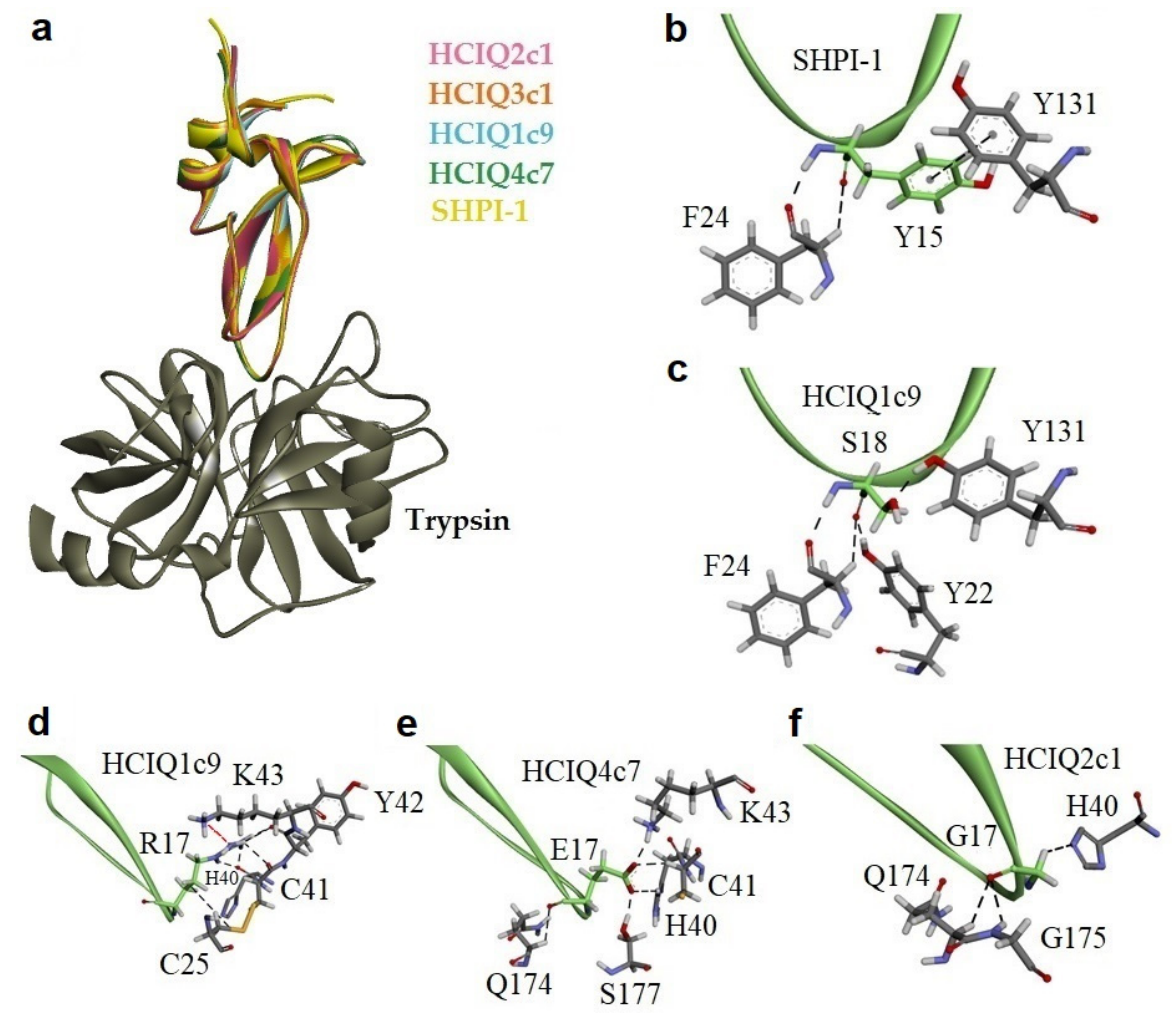
Figure 4. Comparative models of the peptide complexes with trypsin. ( a ) Ribbon representation of peptide complexes. Intermolecular interactions of residues at positions P1’ ( b , c ) and P2’ ( d – f ) with trypsin molecule. Residues are presented as sticks; hydrogen, oxygen, nitrogen, and sulfur atoms are colored in white, red, blue, and orange, respectively. Interactions are shown as dotted lines, unfavorable interactions between Arg17 of HCIQ1c9 and Lys43 of trypsin are shown in red.